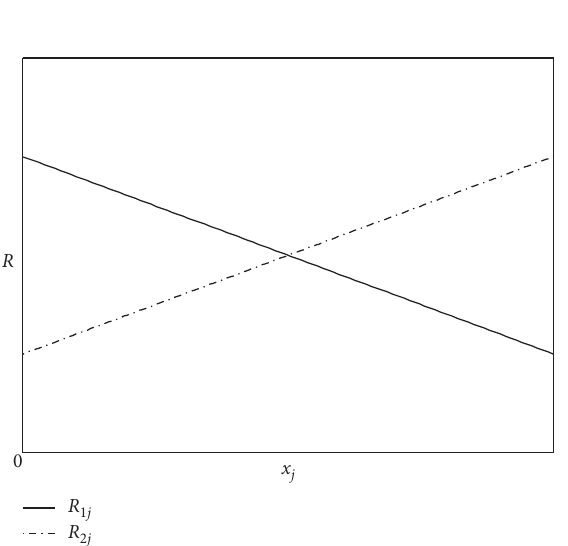
Figure 5: The relation between R and x